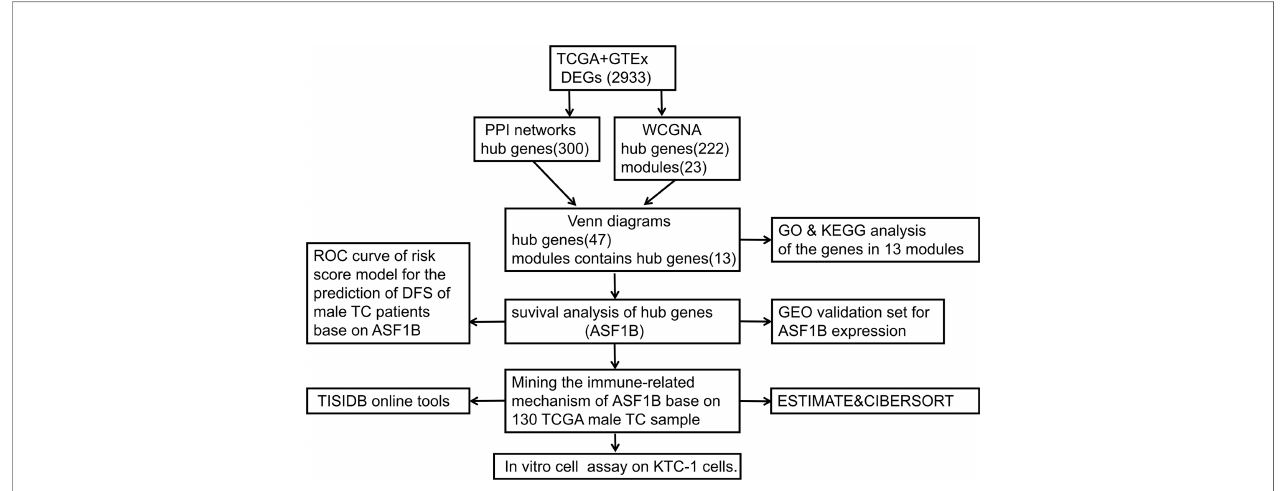
FIGURE 1 | Flowchart of the study